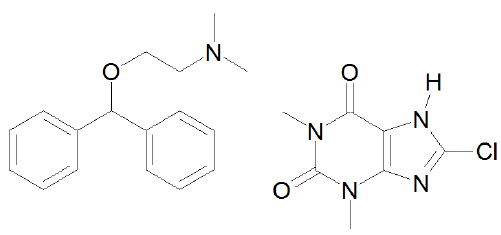
Figure 1. Chemical structure of dimenhydrinate (diphenhydramine +